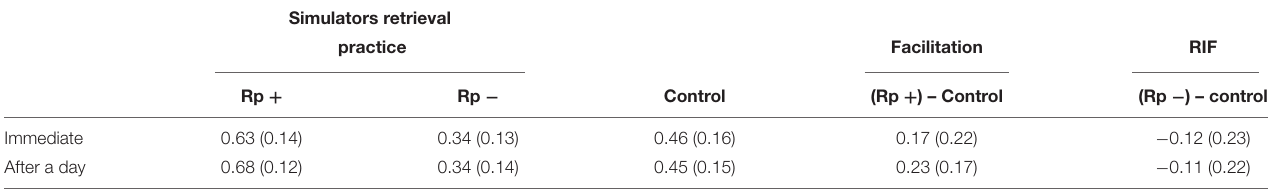
TABLE 1 | Mean proportions of practiced and un-practiced information by simulator groups, and retrieval-practice effects at both immediate and delayed memory tests.